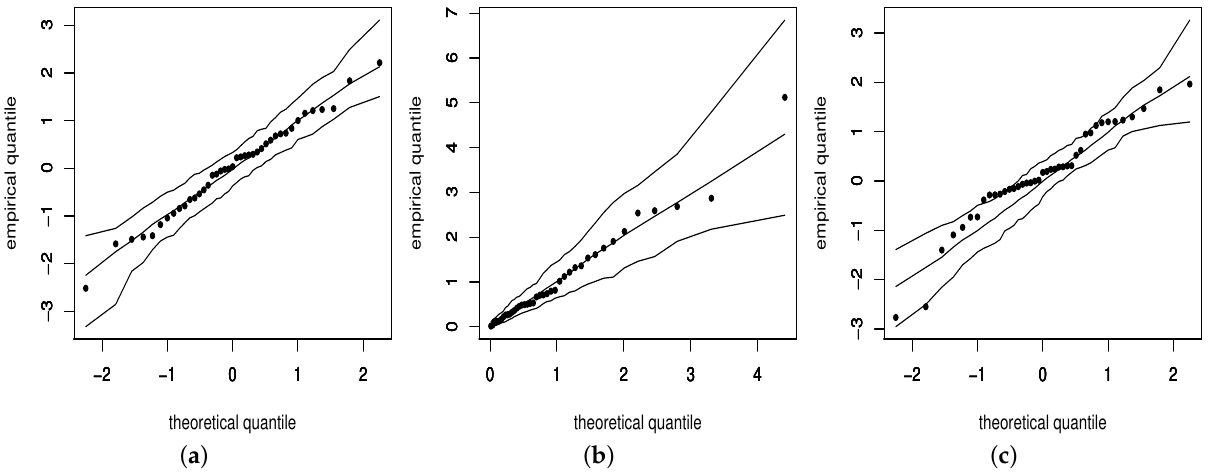
Figure 4. QQ plot with envelope of r RQ Saunders quantile regression model with logarithm link ( c ), using the data of the time to electrical breakdown of an insulating fluid.